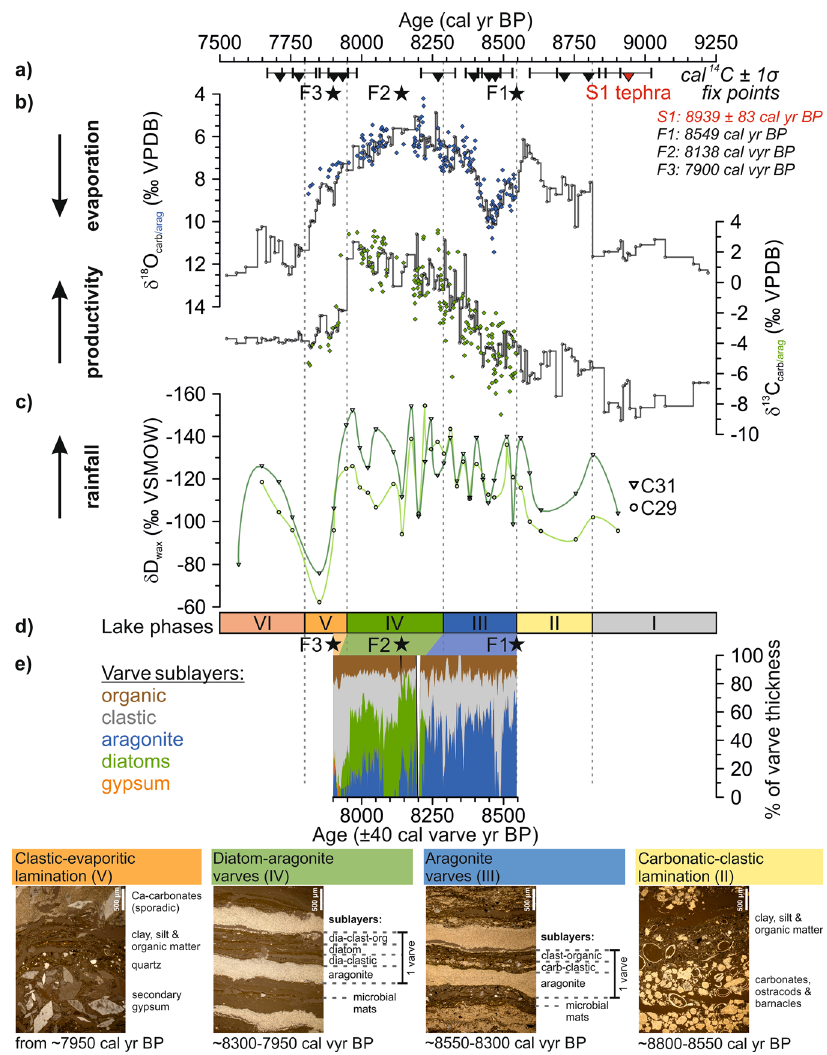
Fig. 2 Palaeolake evolution at Tayma between 9250 and 7500 cal yr BP. a Radiocarbon ages (triangles) and fi x points (stars; see Methods); b δ 18 O carb/arag and δ 13 C carb/arag measured on bulk carbonates (solid lines) and on single aragonite layers (blue and green diamonds); c δ D wax of n -alkanes nC 31 and nC 29 ( δ D nC29, nC31 ); d Tayma lake phases I – V and wetland phase VI; e varve sublayers expressed as % of varve thickness for the varve